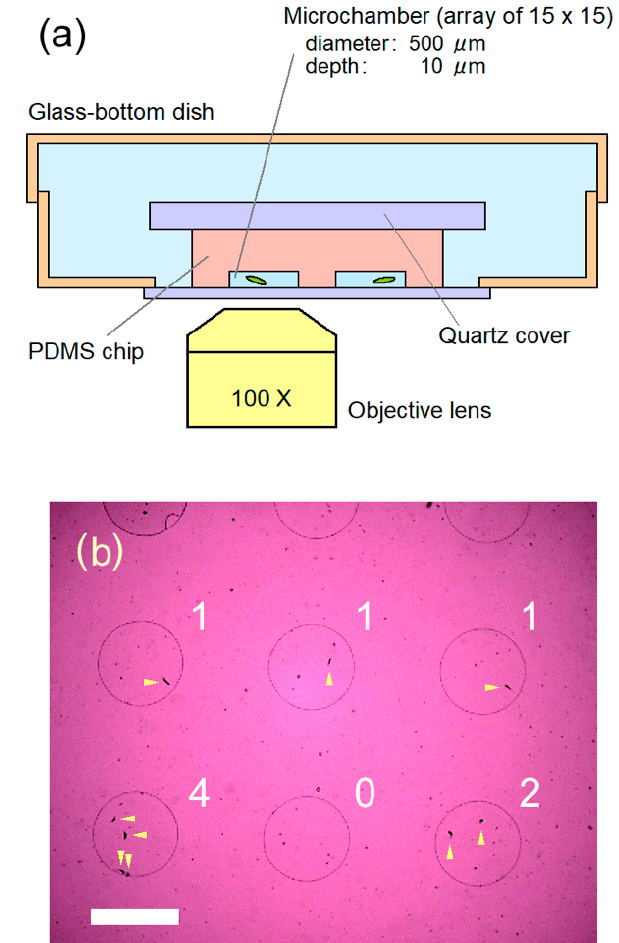
Figure 1. ( a ) Schematic drawing (cross-section, not in scale) of the microfluidic device used in this study. Some of microchambers held a single cell inside, by pressing down the soft porous PDMS chip onto the cell culture solution placed on the glass of the dish. The glass-bottom dish was then filled with pure water to prevent the microchambers from drying. The cells in the closed microchambers can survive three days or more. ( b ) A representative image of cells in confinement in our microfluidic device, observed with an objective lens of 4X. Numbers in the figure show the number of cells confined in each microchamber, and arrows indicate the cells. Scale bar, 500 µ m. We also elucidated the motility of parental and daughter cells under a long-term millimeter-scale observation. Square microchambers with a side length of 2.5 mm and a depth of 100 µ m [16] were used with a 5X objective lens (MPlanFLN 5X/0.15, Olympus, Tokyo, Japan). We confined a single SM-ZK cell in the microchamber and tracked its swimming traces to measure the time point at which the parental cell stopped swimming to initiate cell division (T1), and the time point at which the two daughter cells started swimming after cell division (T2, T3). The non-swimming period (T2 − T1) represents the duration of cell division, whereas difference in swimming start times (T3 − T2) represents the growth difference between two daughter cells. All the above experiments were performed at room temperature (23–26 ◦ C) in CM medium with 0.1% ethanol as a carbon